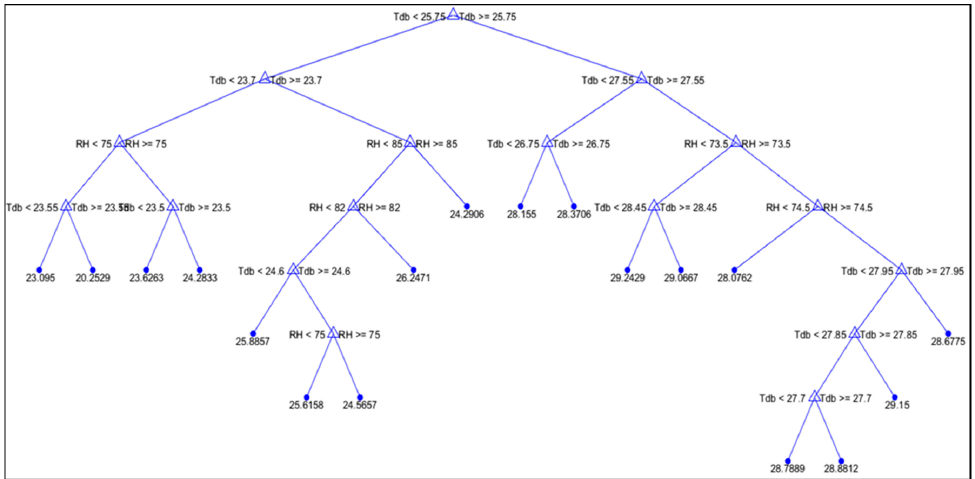
Figure 3. Visual decision tree for the ET output variable (°C).